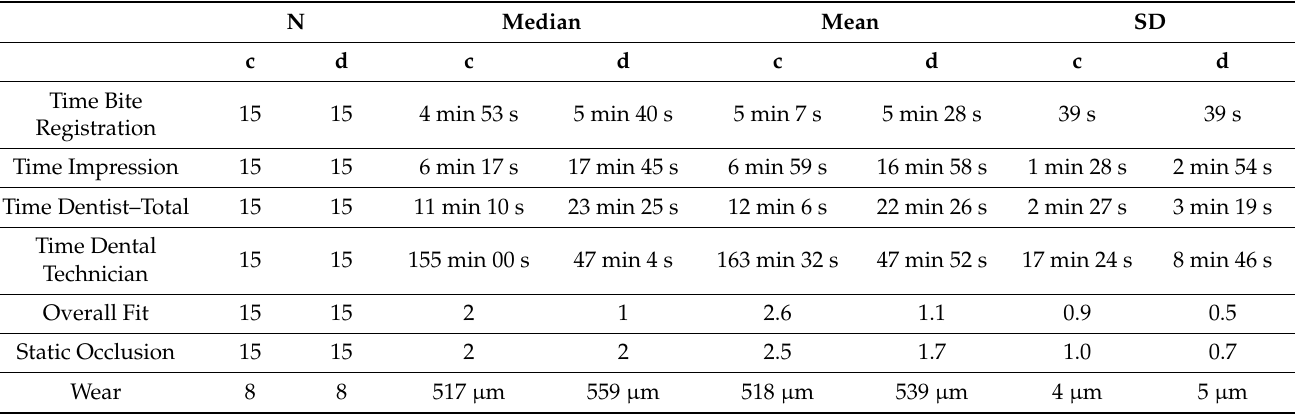
Table 2. Results for the conventional and digital workflow showing the duration for the dentist and the dental technician, the overall fit, the static occlusion, and the